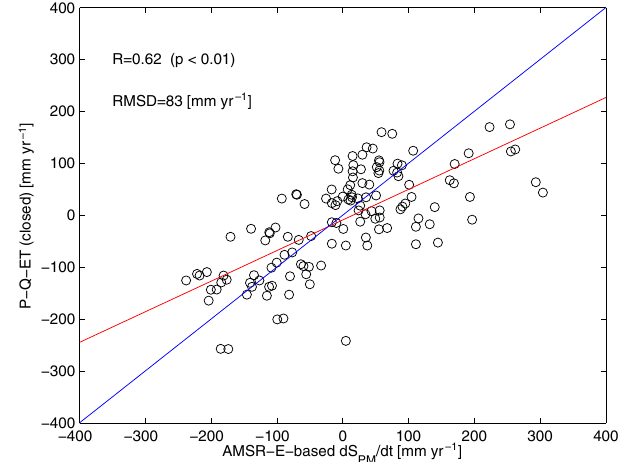
Figure 6. The impact of K PM in Eq. (5) on the RMSD between d S PM / d t and P − Q − E T . Also plotted is the standard deviation of P − Q − E T (i.e., the RMSD incurred by neglecting annual d S / d t ) and the value of K PM defined by the variance matching approach in Eq. (6).